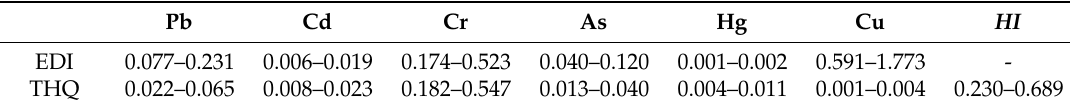
Table 11. Estimate daily intakes (EDI, µ g · kg − 1 · bw · day), target hazard quotients (THQs) and